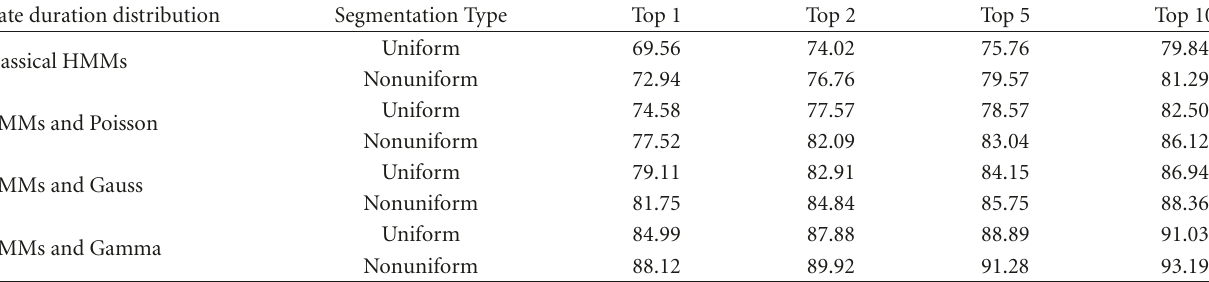
Table 1: Mean recognition results using each time 3 datasets for training and one data set for testing, and a whole word model training method .